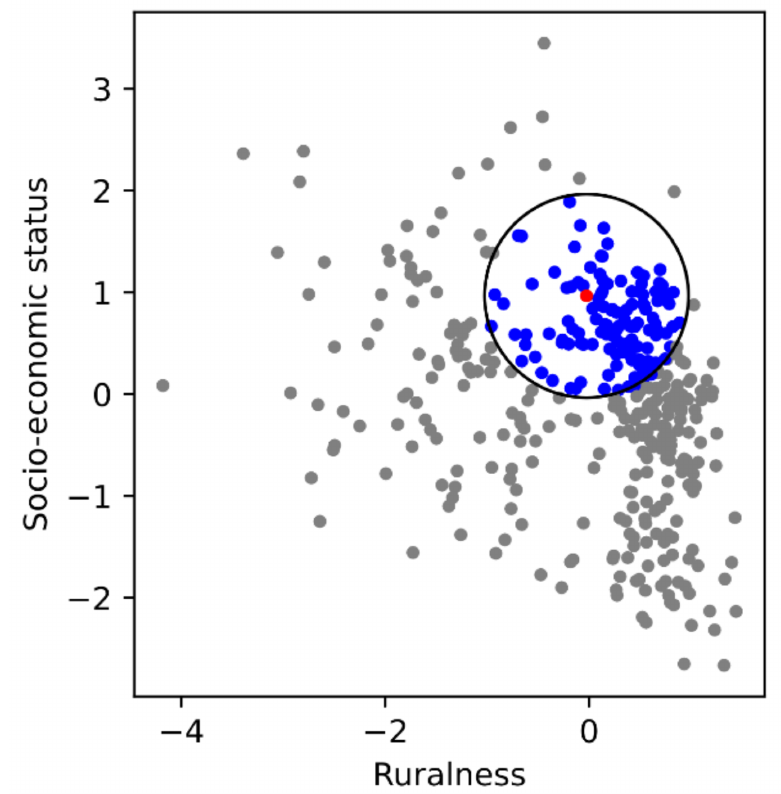
Figure A2. Peer group identification for one example district (city of Koblenz). Red dot represents district for which peers are to be identified, blue dots represent peer districts, grey dots represent districts not considered during peer group normalization for this particular